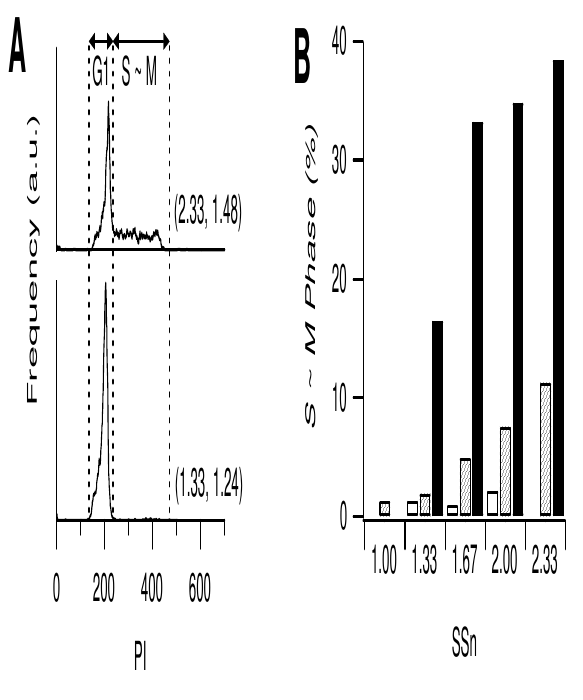
Figure 6 Cell cycle of the sorted cells in the twelve subfrac- tions . Live cells were sorted according to the twelve sub- fractions, then fixed and stained with PI. A: Two examples of PI profile. Upper trace: ( SSn , FSn ) = (2.33, 1. 48), lower trace: (1.33, 1.24). The left peak corresponds to the G1 phase and the right region corresponds to S, G2 and M phase. B: Per- centage of S, G2 and M phase cells. Shading corresponds to that in Fig.